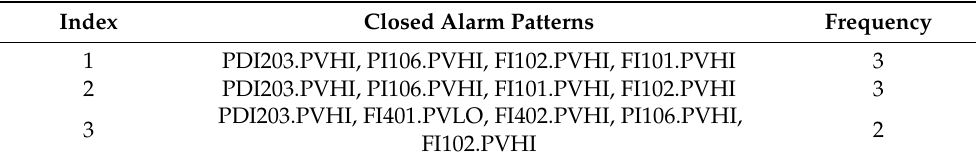
Table 10. Alarm patterns extracted by